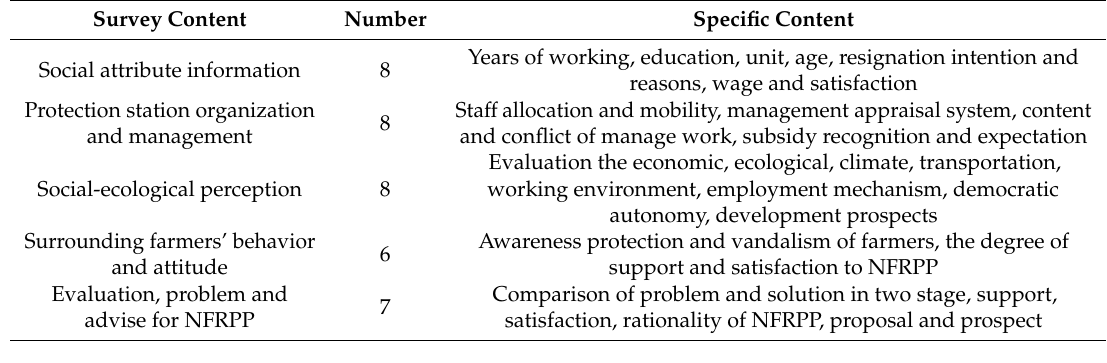
Table 1. Details of the questionnaire.